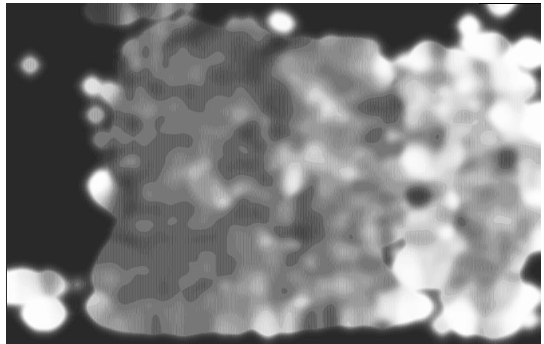
Figure 8. Image representing the module of residual generated for the internal calibration using the Brown’s